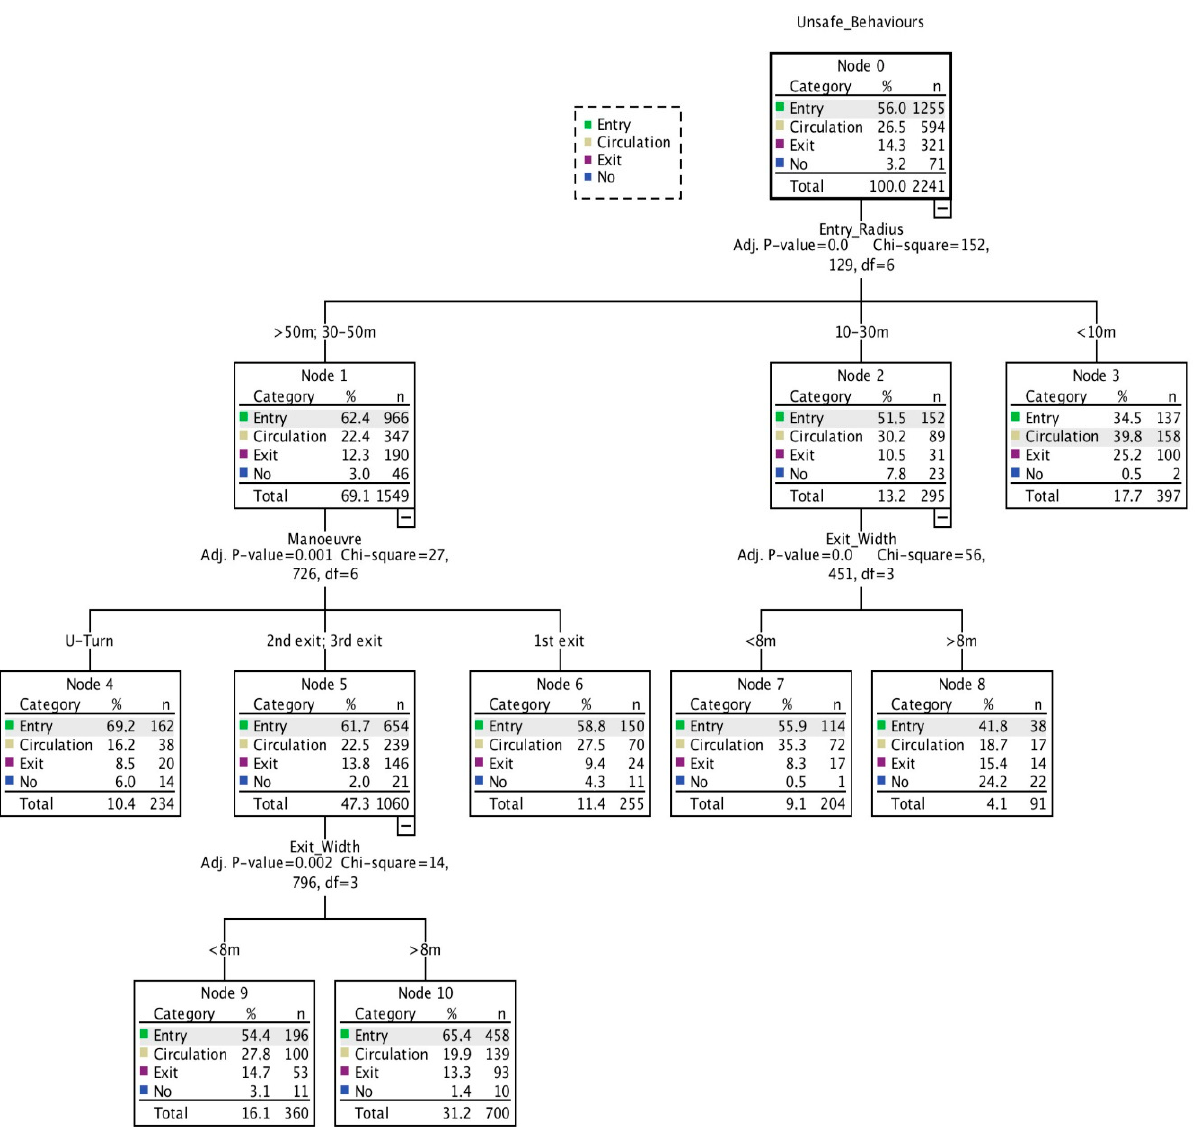
Figure 2. Tree diagram obtained from CHAID analysis for unsafe driving behaviors at double-lane roundabouts.